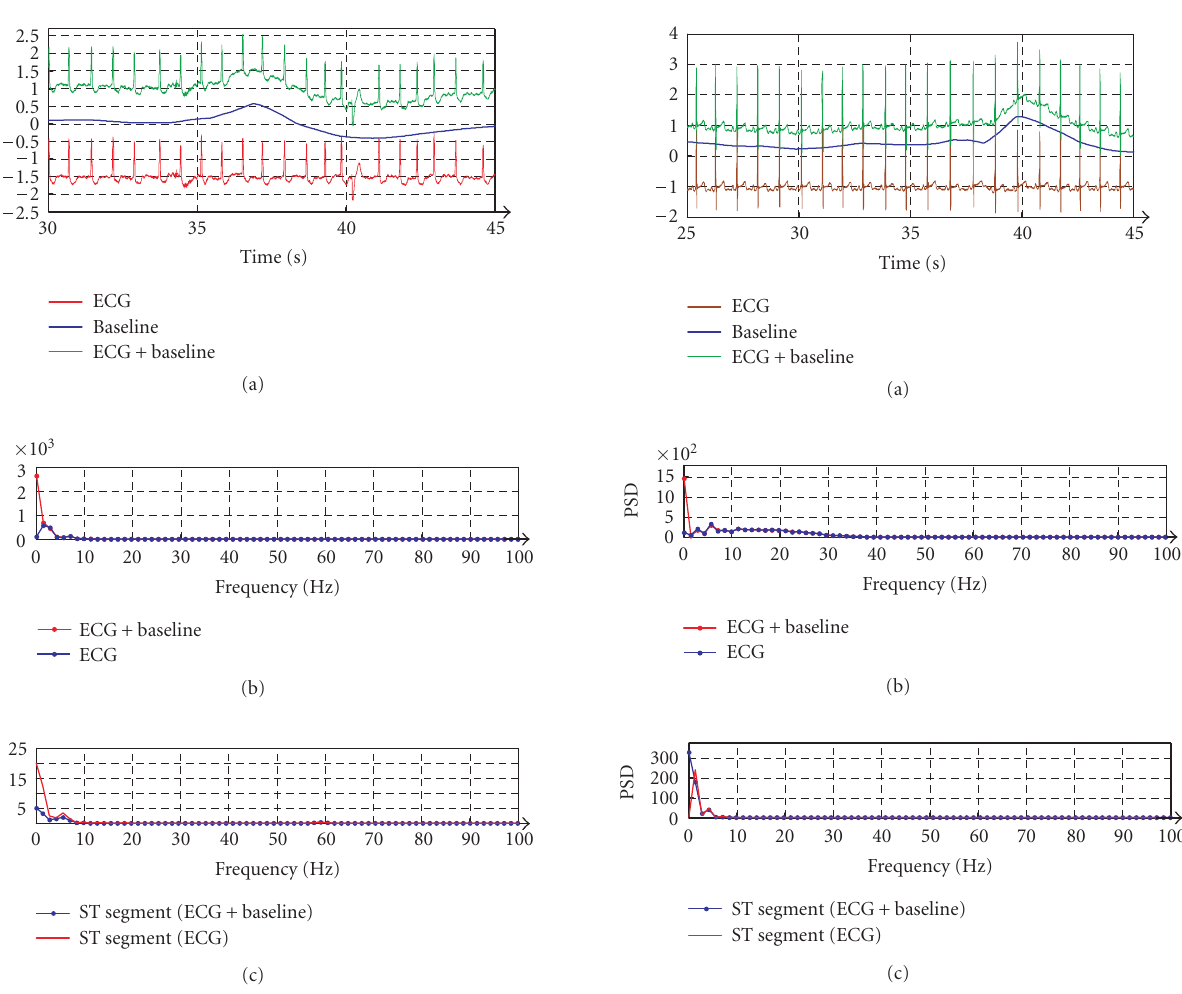
Figure 11: (a) 15 seconds of record “b210-1” highlighted, (b) power spectrum density of record “b210-1,” (c) power spectrum density of ST-segments of record “b210-1.”